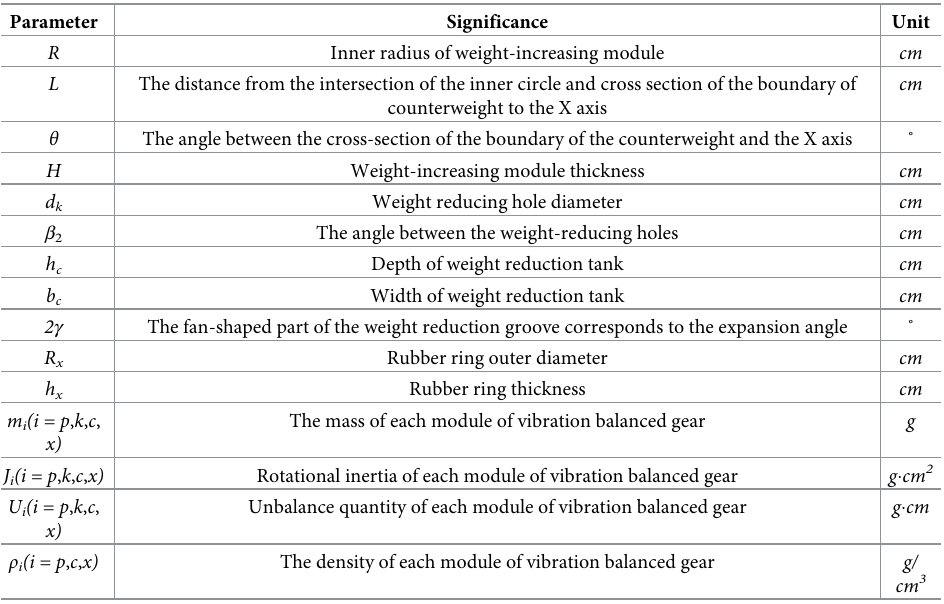
Table 2. Main parameters of the balanced vibration balanced gear. Parameter Significance Unit R Inner radius of weight-increasing module cm L cm